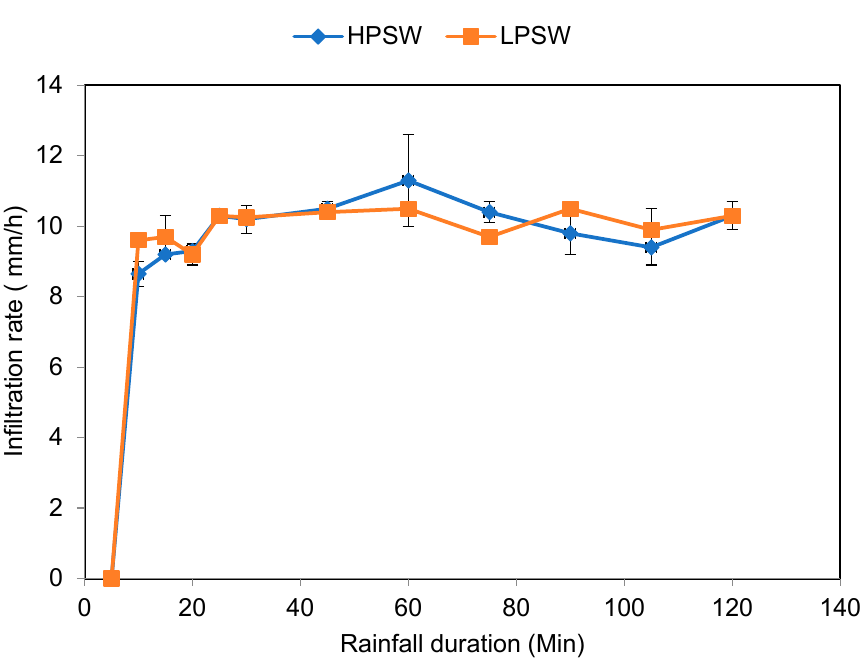
Figure 2. Infiltration rate of the permeable clay bricks during the rainfall experiments of two storm-water.